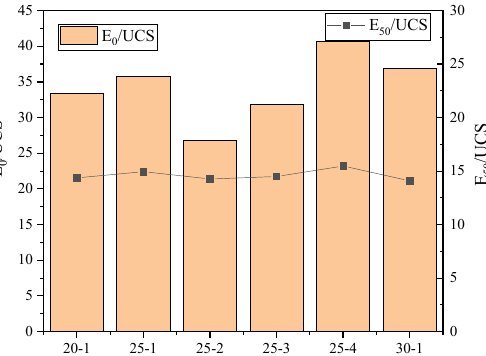
Figure 9. The relationship between the E 0 , E 50 and the UCS of different specimens (bar graph shows E 0 /UCS).